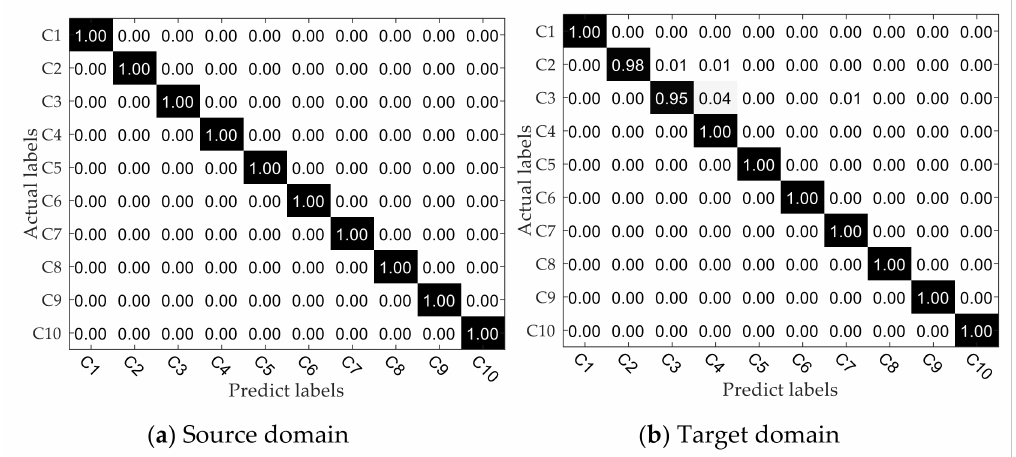
Figure 7. The confusion matrix of the DAN-DAM model in two domains for open